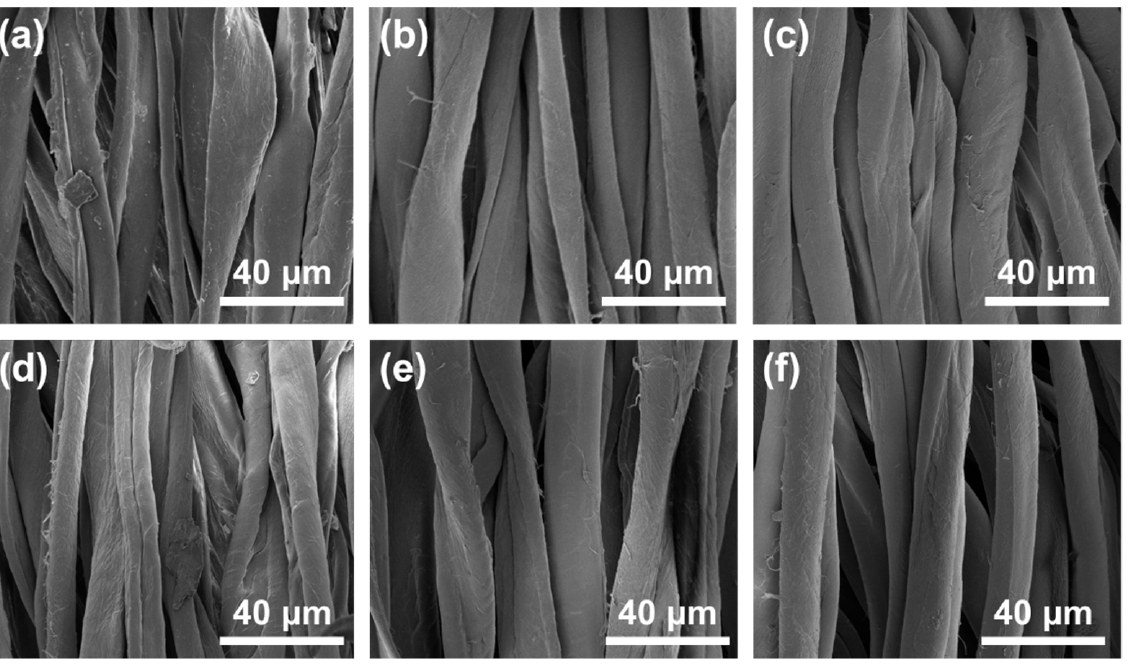
Figure 7. SEM images of different cotton fabrics with 2500× magnification: ( a ) NC, ( b ) PC(EtOH-70), ( c ) PC(NPA-60), ( d ) NCC, ( e ) PCC(EtOH-70), and ( f ) PCC(NPA-60).